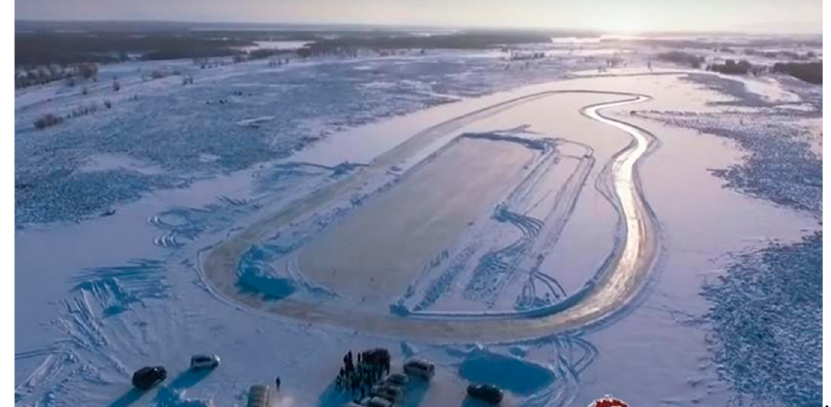
Figure 4. Test site (Russian Federation, Yakutsk, Russia).